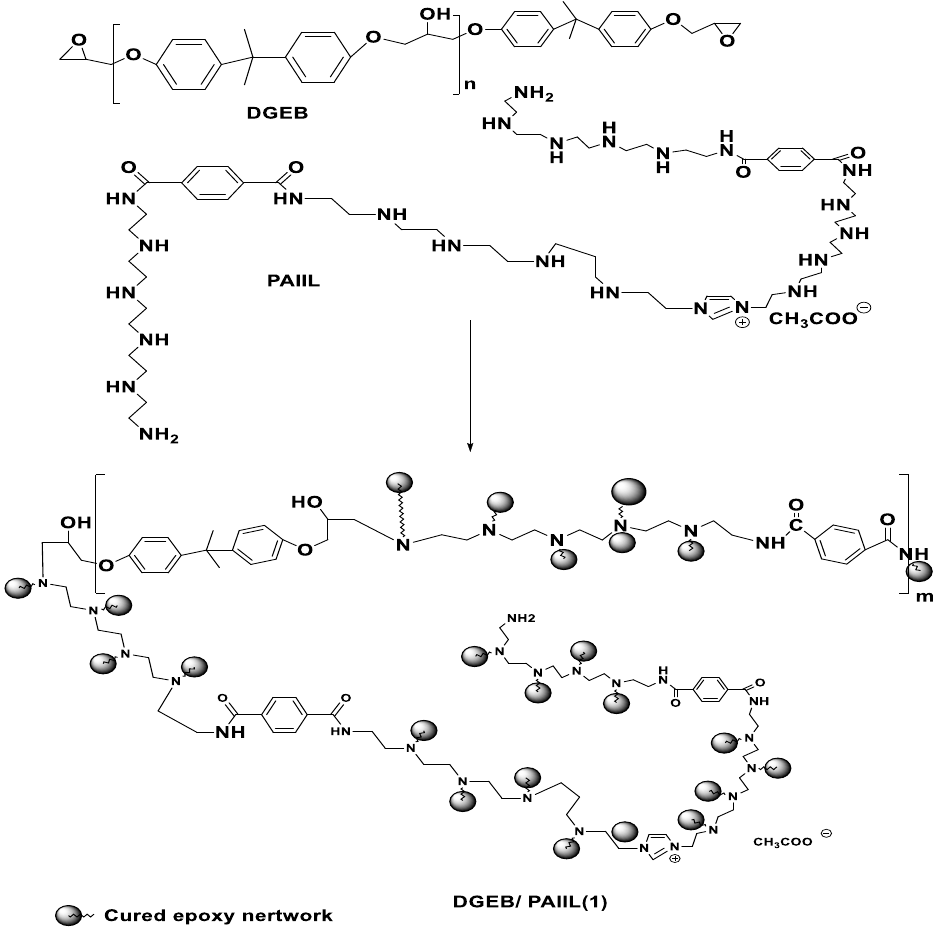
Scheme 2. Curing of DGEB resin with amino-amide groups of PAIIL.